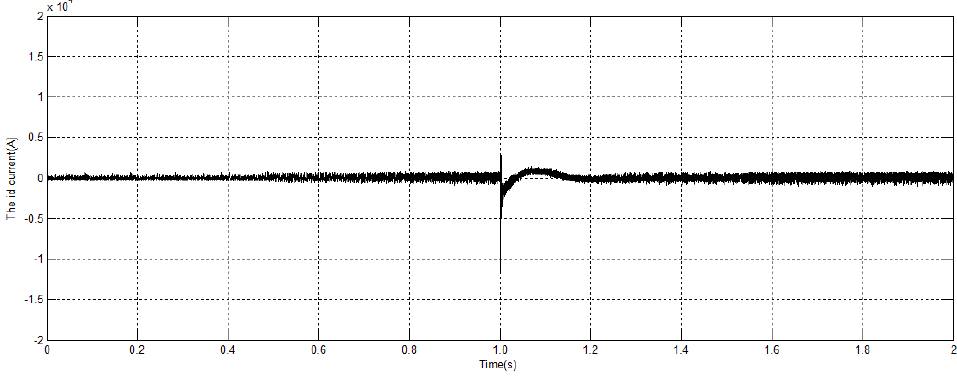
Figure 7. The current simulation curve of the d -axis.